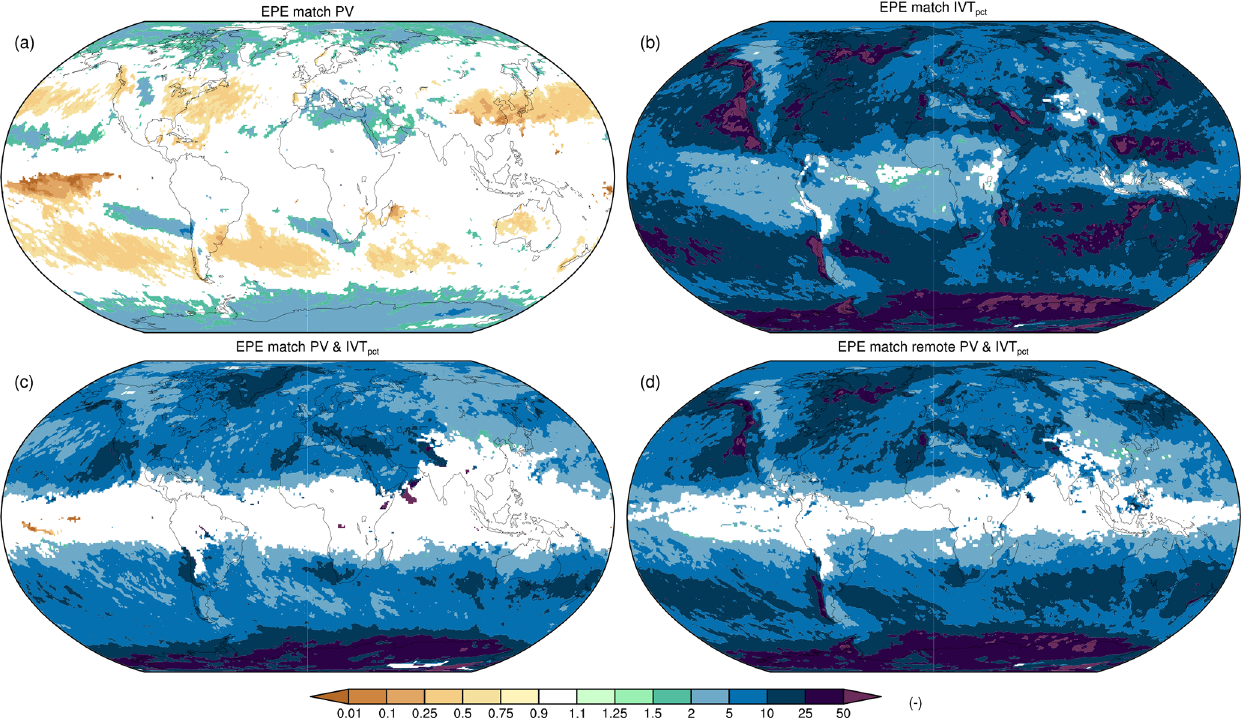
Figure 7. Odds ratios of EPE matches with (a) PV structures, (b) IVT pct structures, (c) combined PV and IVT pct structures with a direct PV influence, and (d) combined PV and IVT pct structures which also allows a remote PV influence, i.e. observed matching odds divided by the matching odds expected under independence of EPEs and the PV and/or IVT structures. Odds ratios are plotted transparently where the link between EPEs and these structures is not statistically